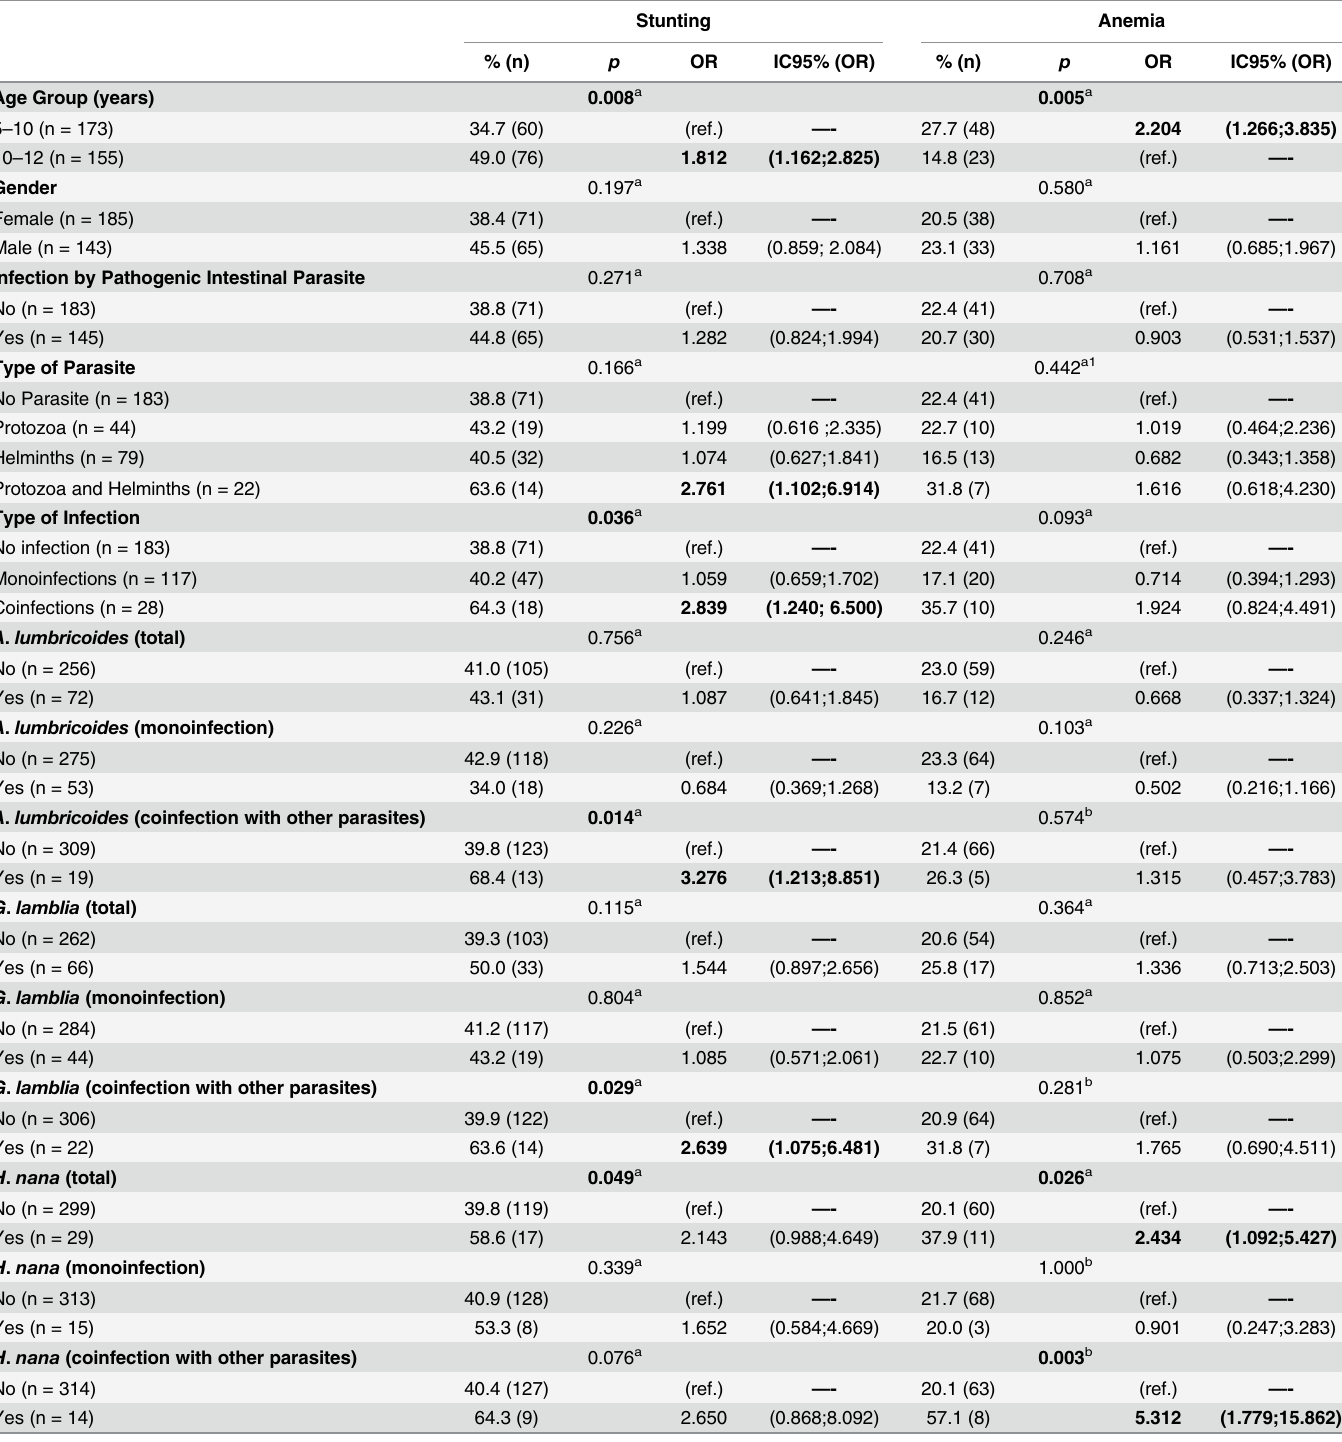
Table 5. Binary regression for stunting and anemia.